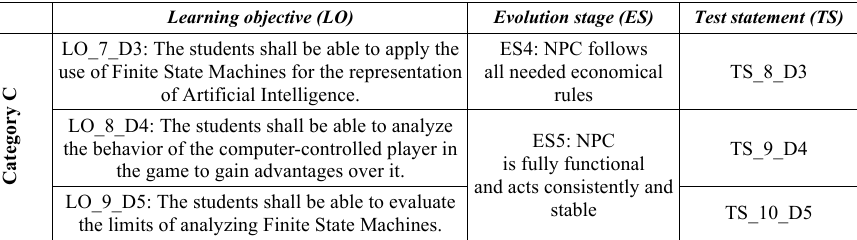
Table 1. Learning objectives, evolution stages and test